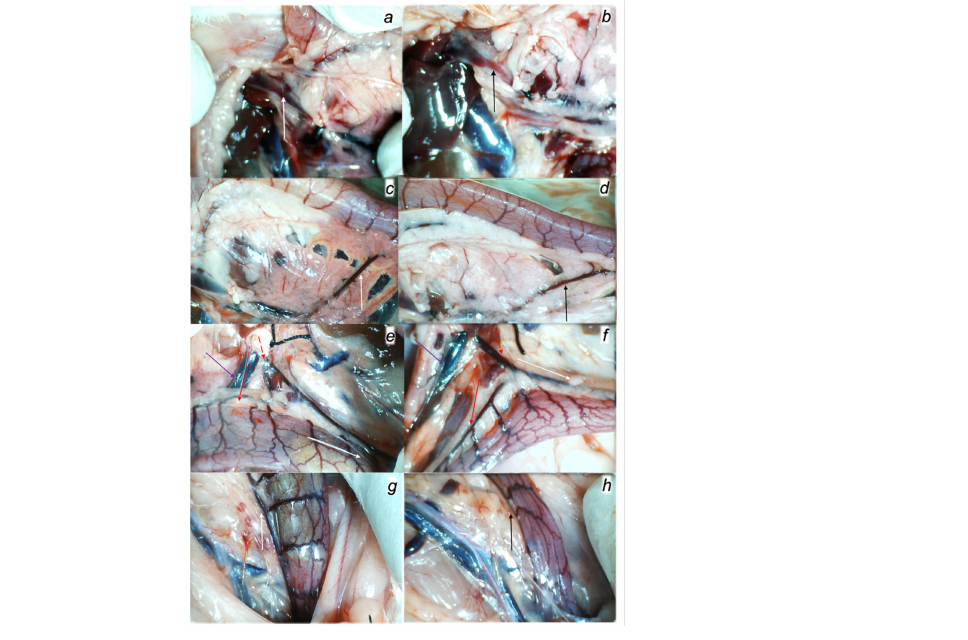
Figure 3. Collateral pathways gross presentation in rats with the occluded end of the superior mesenteric vein in the rats that received BPC 157 therapy (right) or saline medication (left). Portal vein presentation upon inflow of the pyloric vein, congested in controls ( a ) (white arrow) and functioning in BPC 157-treated rats ( b ) (black arrow). Inferior anterior pancreaticoduodenal vein presentation ( c , d ), congested in controls ( c ), and functioning in BPC 157-treated rats ( d ) duodenum presentation and duodenal arcade vessels presentation as follow up to the reestablished communication with the superior anterior pancreaticoduodenal vein (and thereby superior mesenteric vein and portal vein communication in BPC 157 rats ( d )), or vessels failure in controls ( c ). ( e , f ) Presentation of the middle colic vein (full read arrow), inferior mesenteric vein (dashed read arrow), left colic vein and arcade vessels (white full arrow) and superior mesenteric vein (violet arrow) in the control rats ( e ) and in the BPC 157-rats ( f ), as the alternative pathway toward inferior caval vein. ( g , h ) Rectal veins presentation as tortuous veins presentation in controls ( g ) (white arrow) and counteraction in BPC 157 rats ( h ) (black